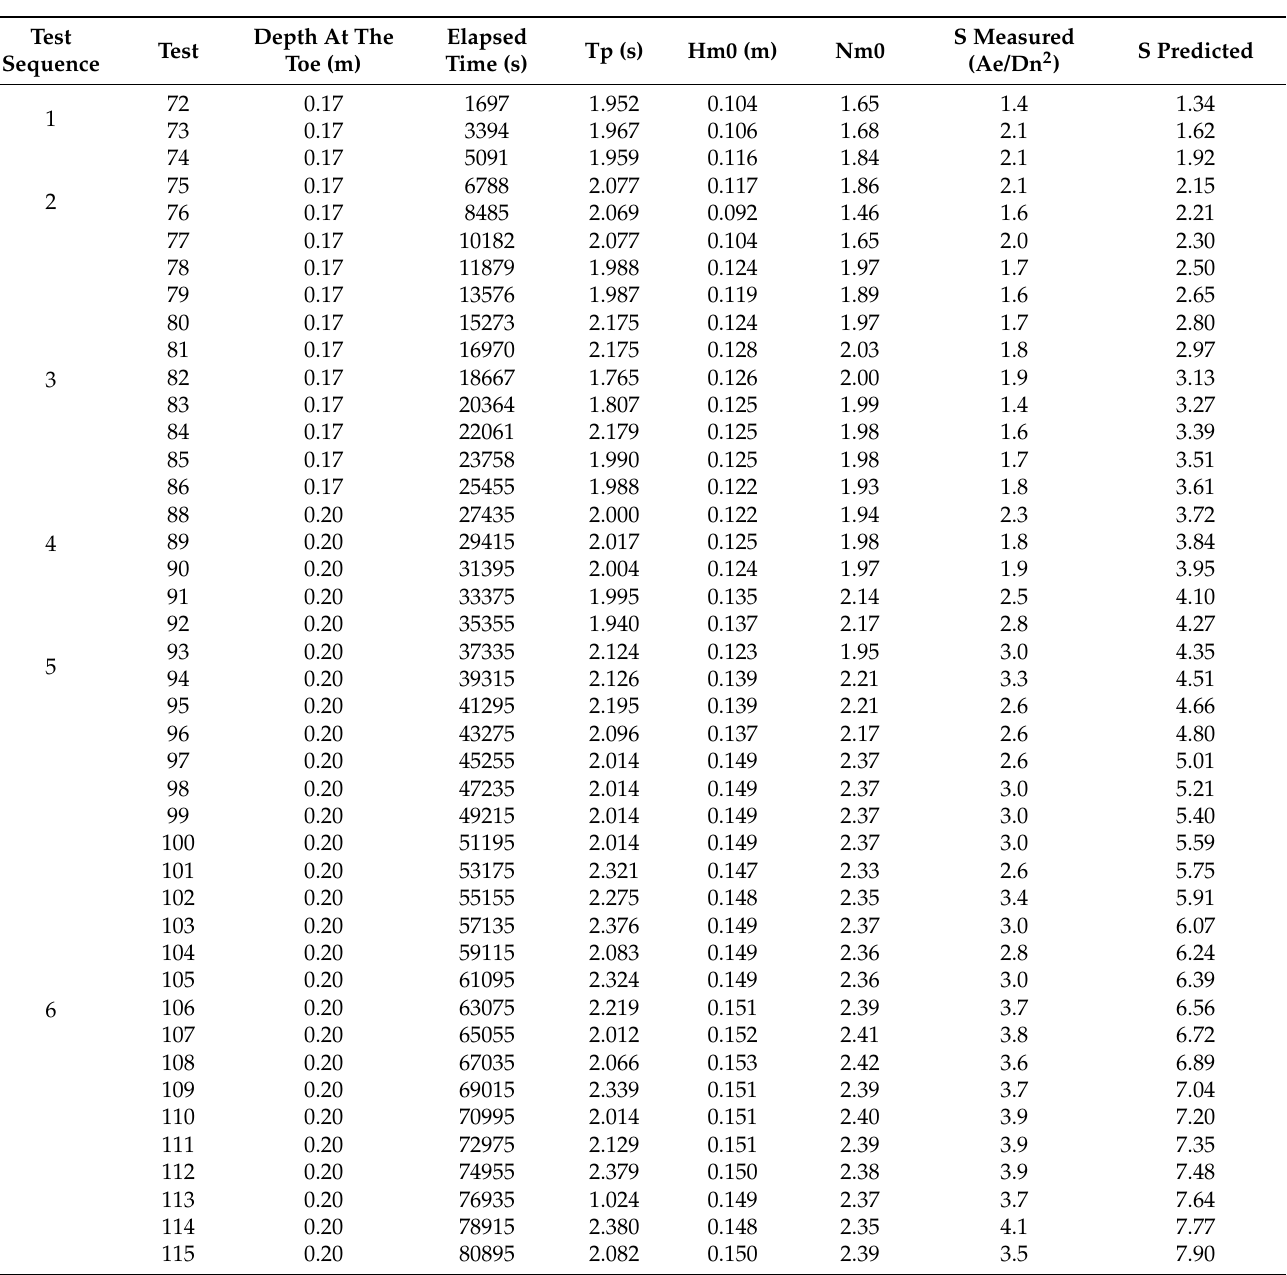
Table 3. Damage values (S) measured and predicted by Melby’s formula (Equation (6)) and coeffi- cients for armour layer made of